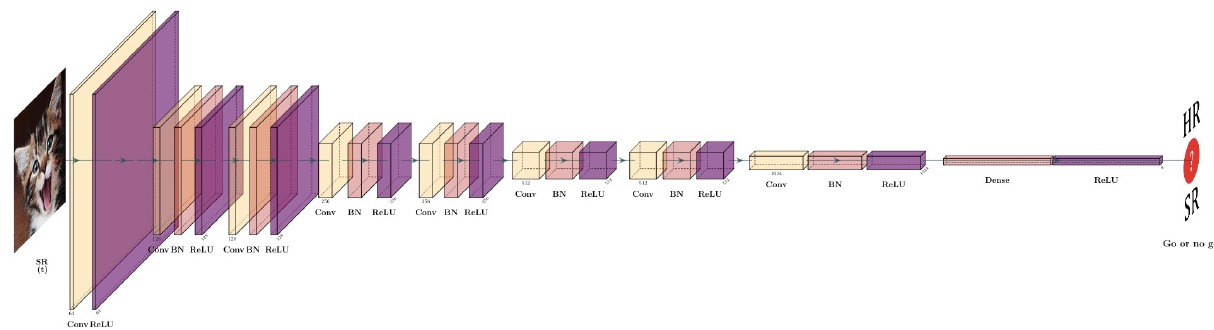
Fig. 4 ResNet architecture for MISR that is composed of three tiles of five blocks where each block consists of two convolutional layers with 3 × 3 kernels, a stride of 1 and padding of 1. The network uses Parametric ReLUs [42] for its activations.